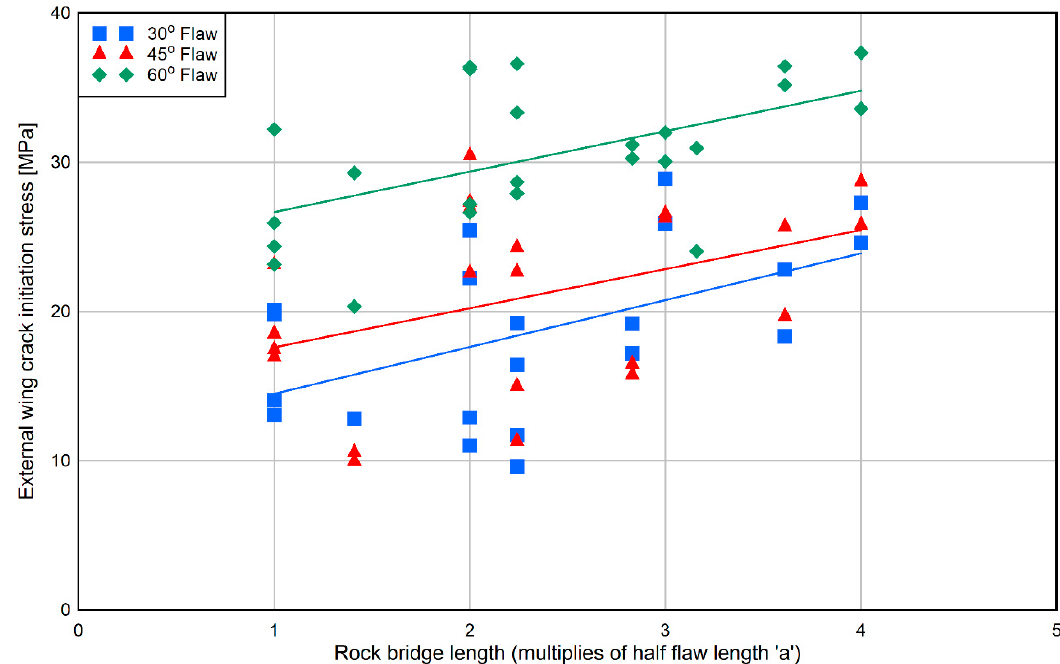
Figure 7. External wing crack initiation stress with respect to the rock bridge length.